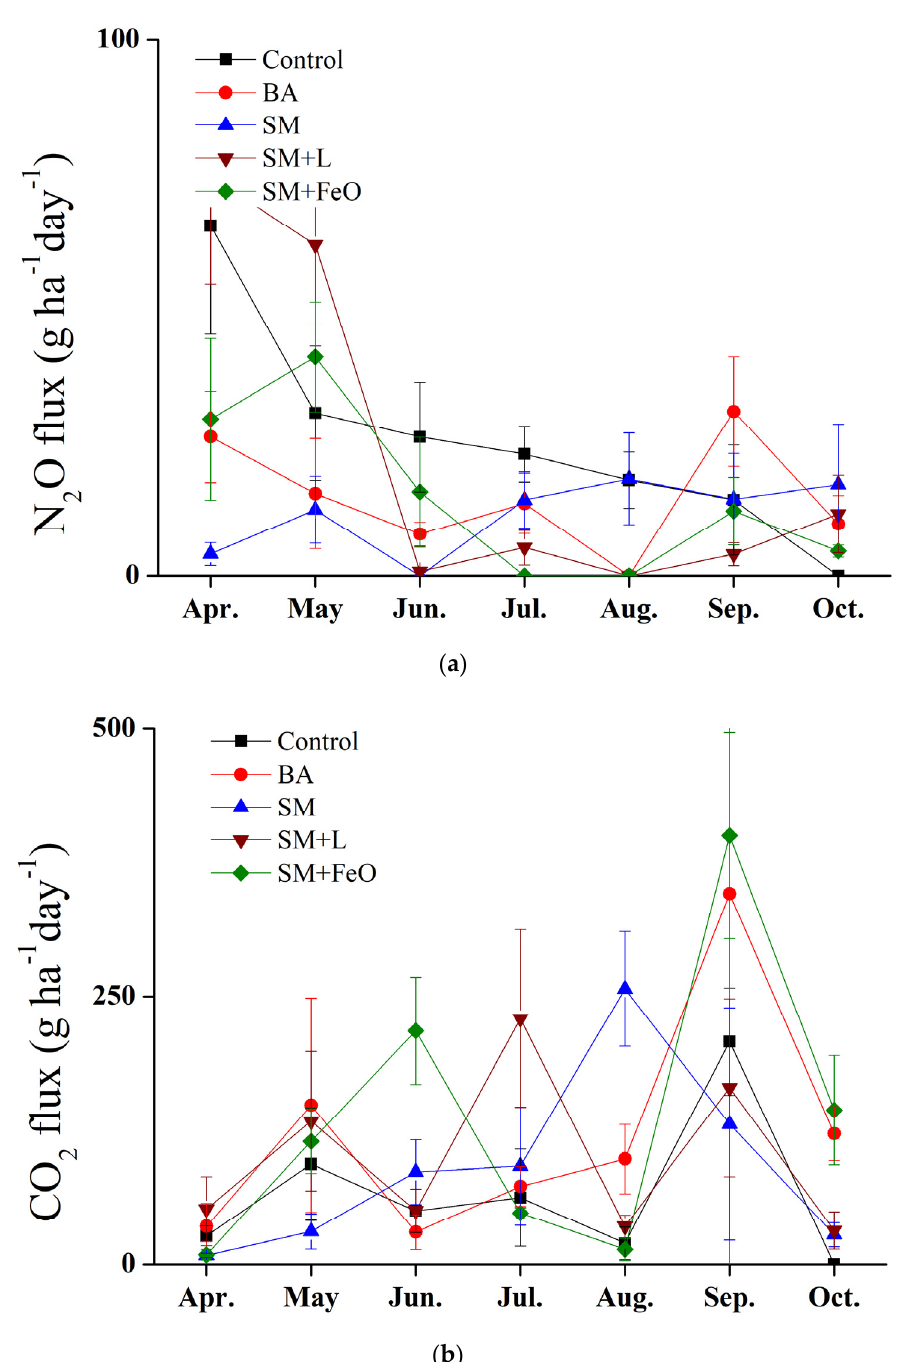
Figure 1. Monthly GHG flux, ( a ) N 2 O flux, and ( b ) CO 2 flux.